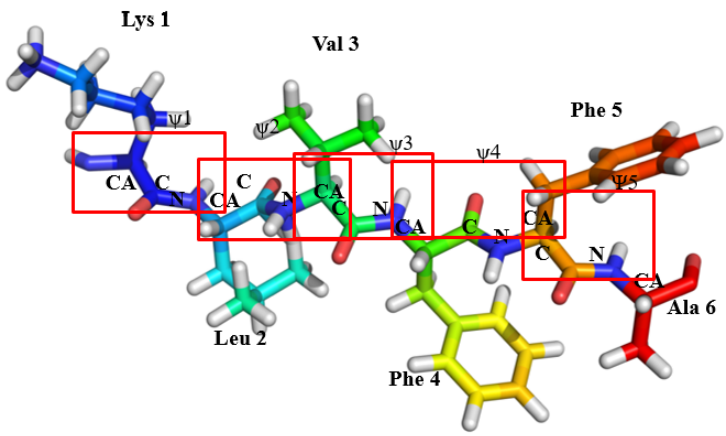
Figure 1. The schematic represents of monomeric form of KLVFFA, with 5 ψ angles in total with one corresponding to each peptide bond. The red box indicates the location of different peptide bonds in the KLVFFA sequence.